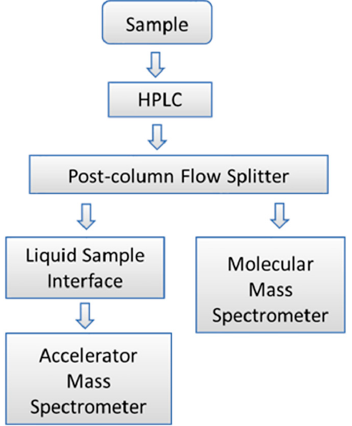
Figure 2. Block diagram showing the PAMMS instrument